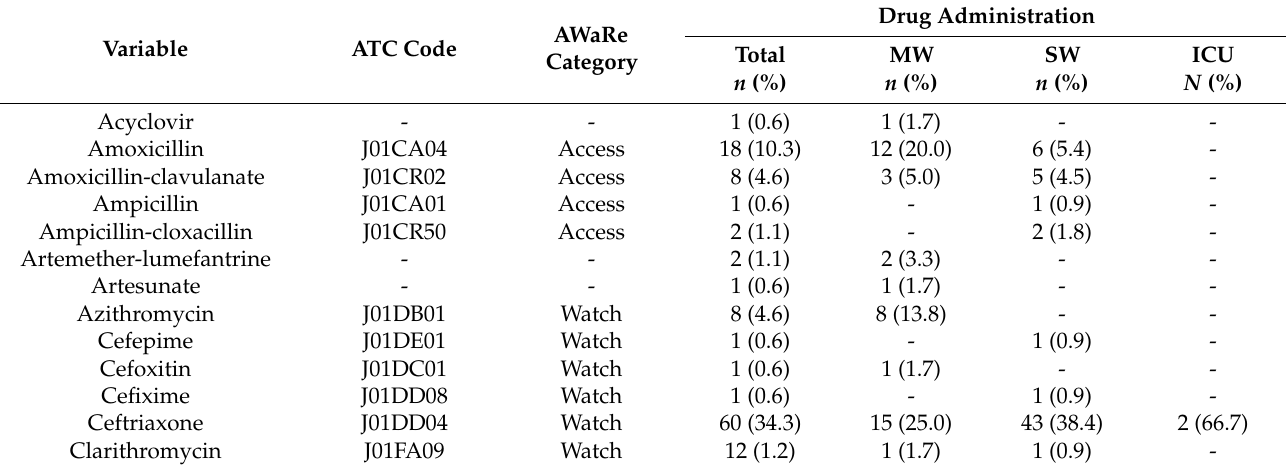
Table 2. Frequency of administration of antibiotics and AWaRe